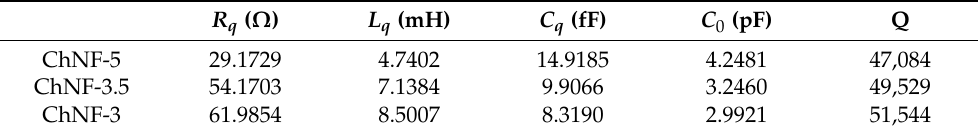
Table 1. Equivalent circuit parameters of the bare QCM in the experiment.